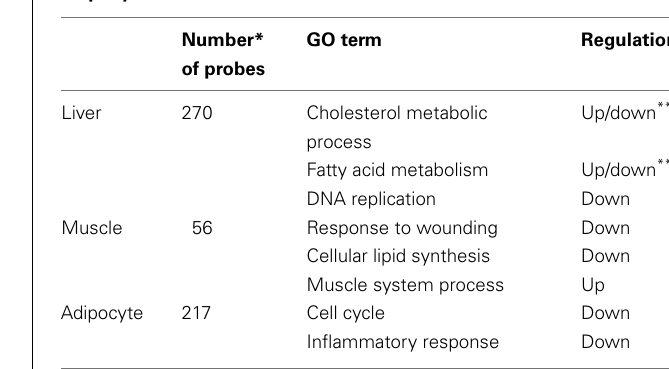
Table 1 | Results of DNA microarray analysis on liver, muscle, and adipocyte.